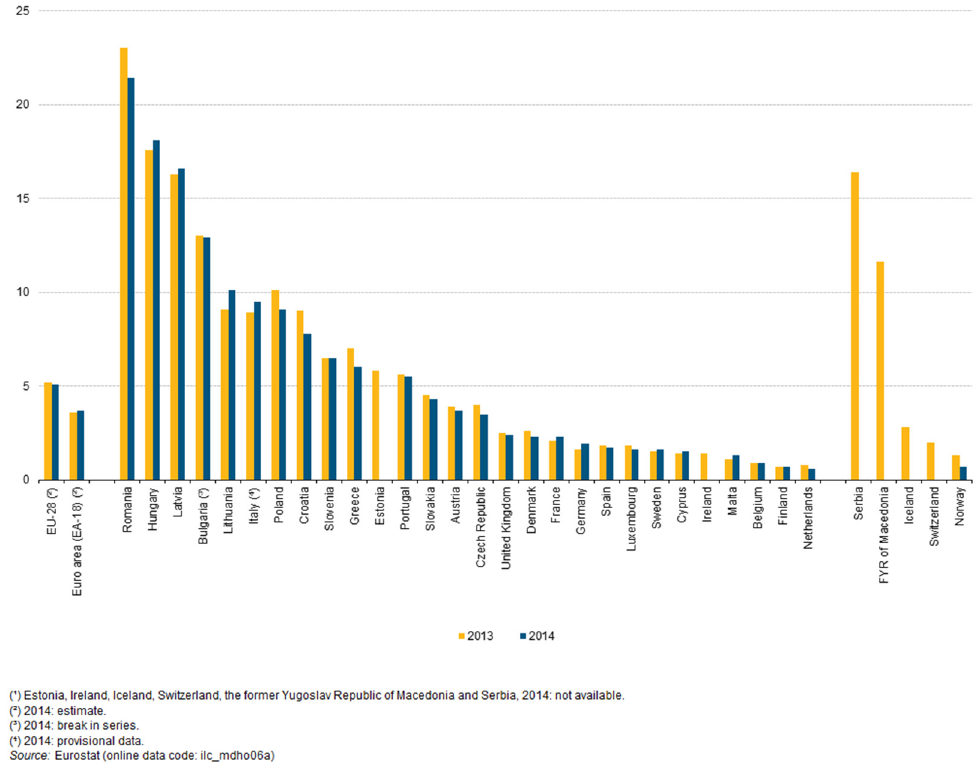
Figure 2 . Severe housing deprivation, 2013 and 2014, % of population. Source: Eurostat [50] © European Union, 1995–2013.